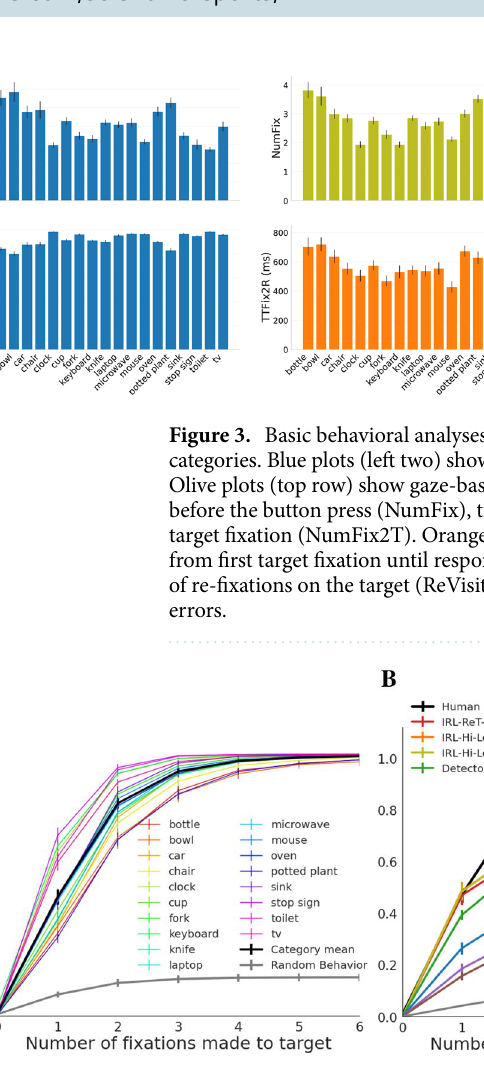
Figure 4. ( A ) Cumulative probability of fixating the target (y-axis; target-fixation probability or TFP) as a function of fixation serial position (x-axis; 0–6), shown individually for the 18 target categories (color lines) and averaged over target types (bold black line). The bottom-most function is a Random Behavior baseline obtained by computing target-fixation probability using a scanpath from the same participant searching for the same target category but in a different image. For the 18 target functions, means were computed by first averaging over images and then over participants, and standard errors were computed over participants. For the averaged behavioral data and the Random Behavior baseline (black and gray lines), means were computed by first averaging over images and then over categories, and standard errors were computed over categories. ( B ) TFP functions generated from model predictions on the test images. Names designate a model type (IRL, Detector, Deep Search) and a state representation (ReT, Hi-Low, Hi, C), separated by hyphens. Average behavioral TFP is again plotted in bold black, this time for just the test data (which explains the small differences from the corresponding function in A, which included the training and testing data). The Random Model baseline was obtained by making six movements of the Hi-Low foveated retina, with ISTs after each, and determining whether any of these movements brought the high-resolution central window to the target. Means were first computed over images and then over categories, and standard errors were computed over categories. ( C ) A re-plot of B, but only including data from trials in which the target was successfully fixated within the first six fixations (i.e., search scanpaths that succeed in locating the